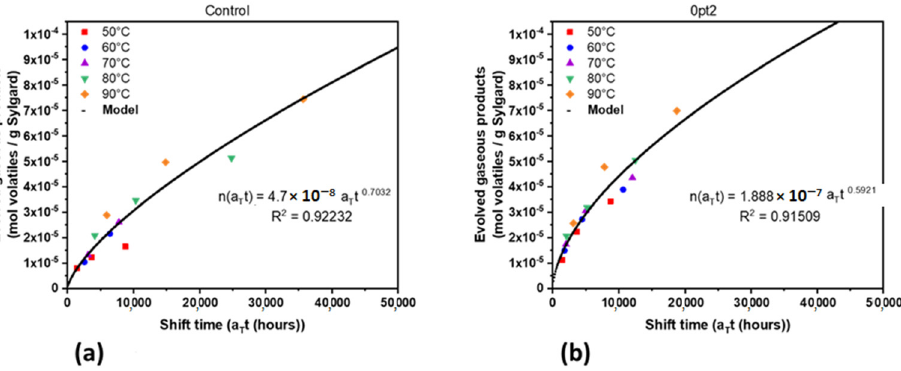
Figure 8. Time–temperature superposition master curve models of the three major evolved gaseous products: ( a ) Controls and ( b ) 0pt2.